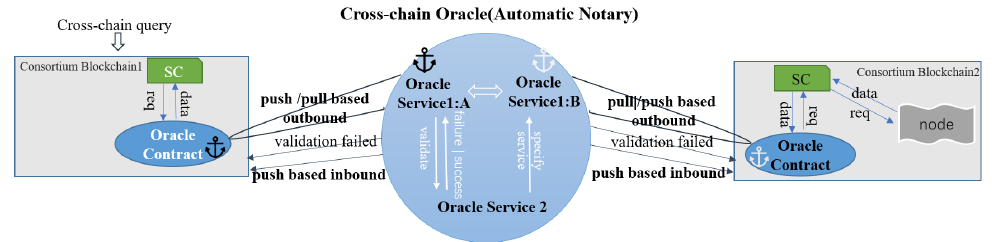
Figure 2. Inter-chain interaction